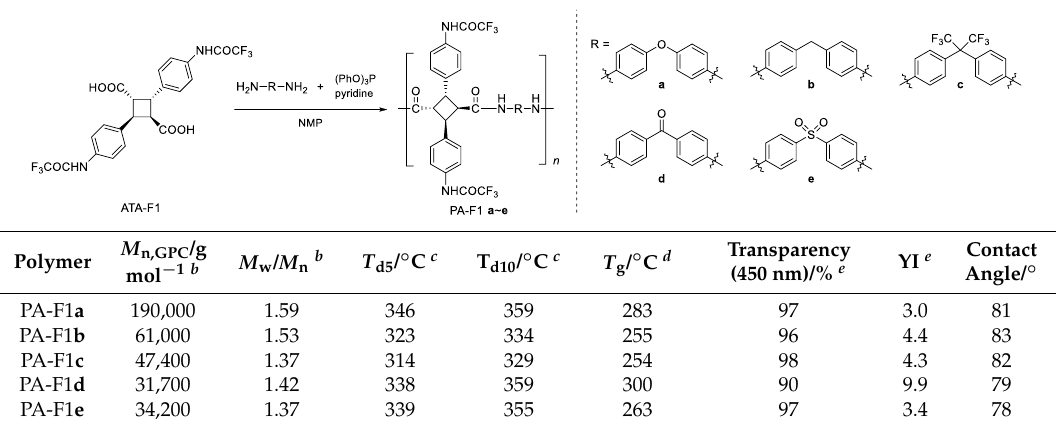
Figure 3. 1 H NMR spectra of the PA-F1 a , PA-F1 b , PA-F1 c , PA-F1 d , and PA-F1 e (Solvent, DMSO- d 6 ).